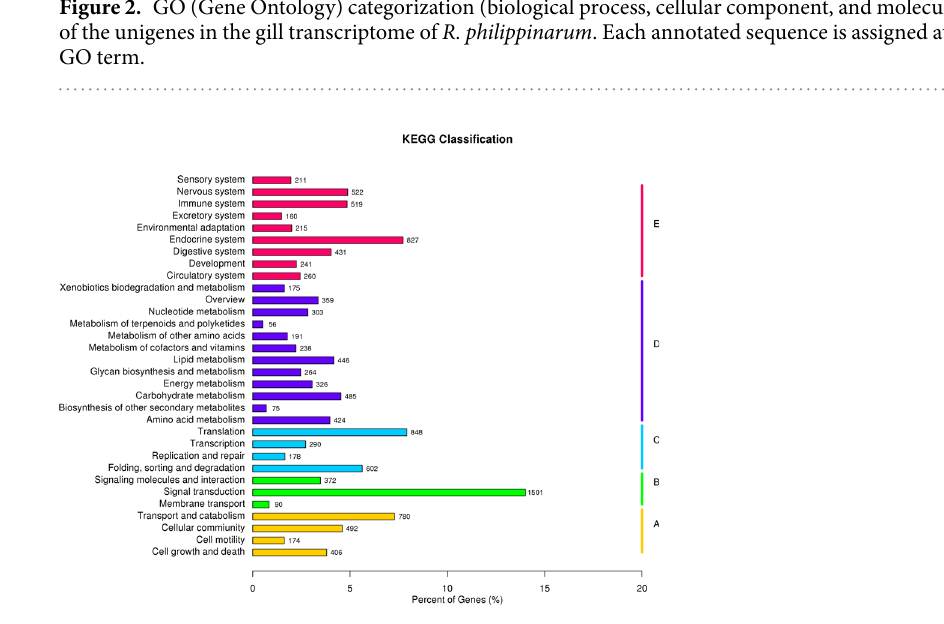
Figure 3. KEGG (Kyoto Encyclopedia of Genes and Genomes) assignment of unigenes in the gill transcriptome of R. philippinarum . ( A ), Cellular processes; ( B ) Environmental information processing; ( C ) Genetic information processing; ( D ) Metabolism; ( E ) Organismal